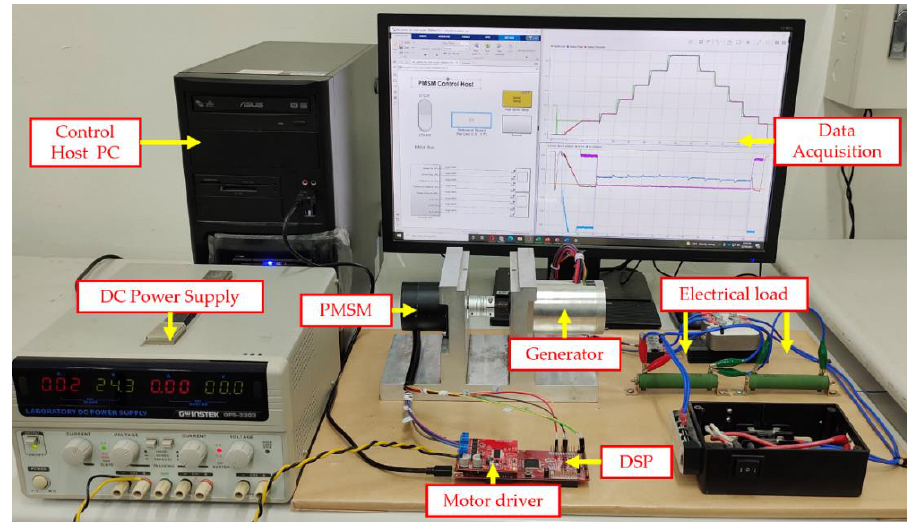
Figure 15. Experimental hardware platform.